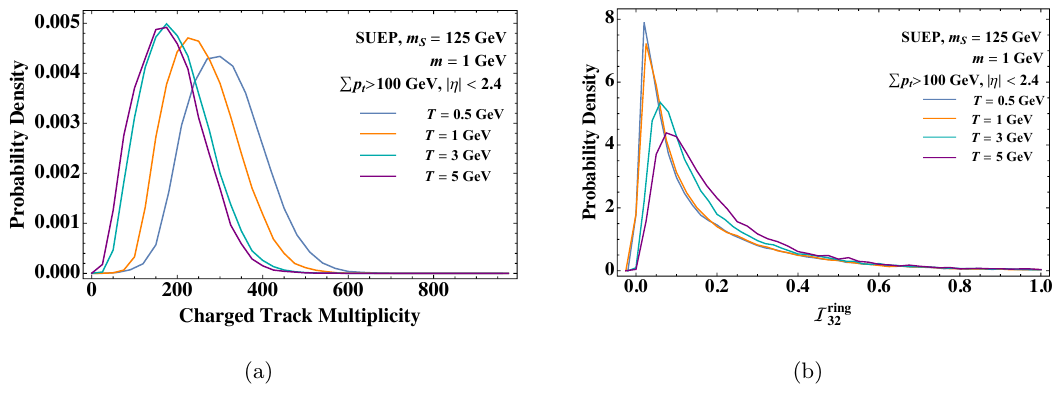
Figure 21 . The distributions of (a) charged track multiplicity and (b) ring-like event isotropy for SUEP samples of mass m = 1 GeV and temperatures T = f 0 : 5 ; 1 ; 3 ; 5 g GeV. We see that the distributions of track multiplicity for T = f 3 ; 5 g GeV are nearly overlapping, whereas the curves with similar event isotropy are T = f 0 : 5 ; 1 g GeV. For additional values of m , see appendix